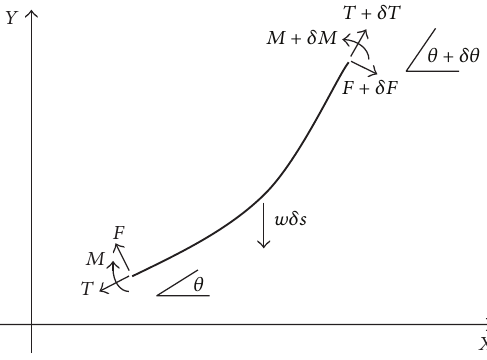
Figure 4: Geometrical relationship for lowering step.